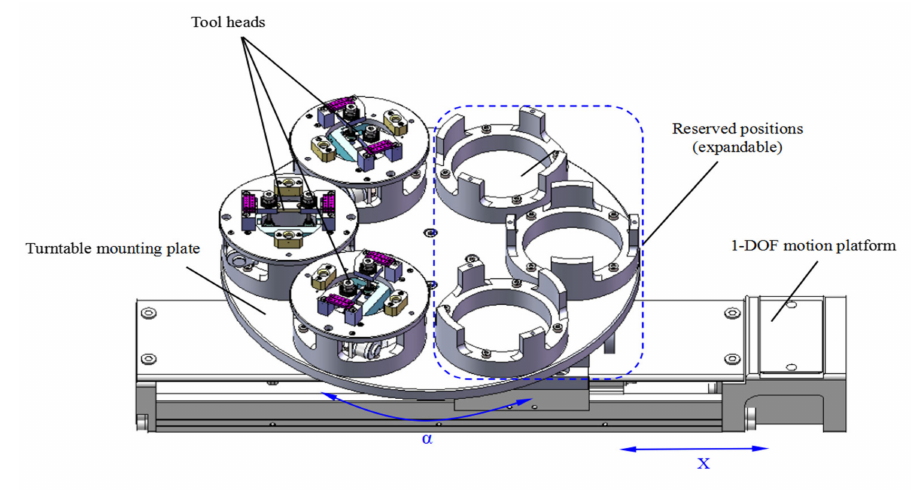
Figure 5. Exchangeable tool